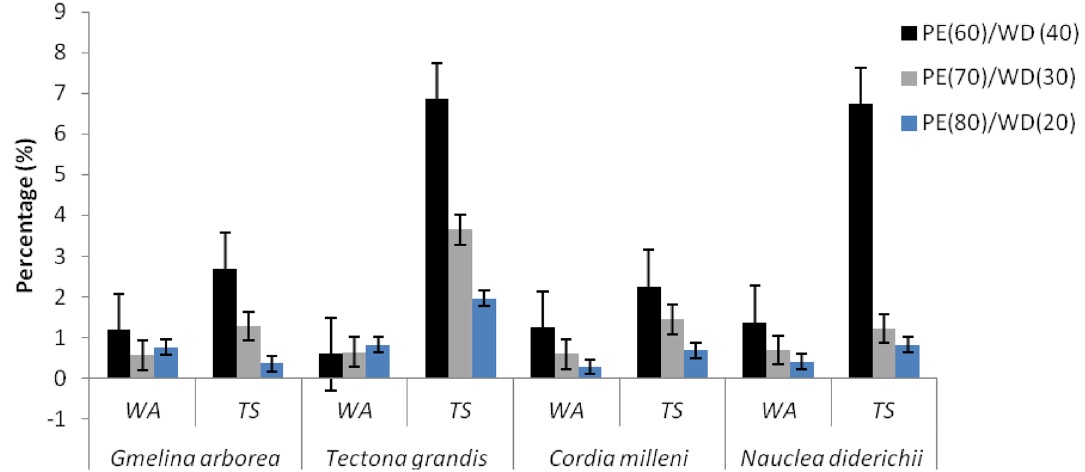
Figure 4. Dimensional stability observed from extruded-compressed biopolymer composites. WA water absorption, TS thickness swelling, PE Polyethylene, WD wood.